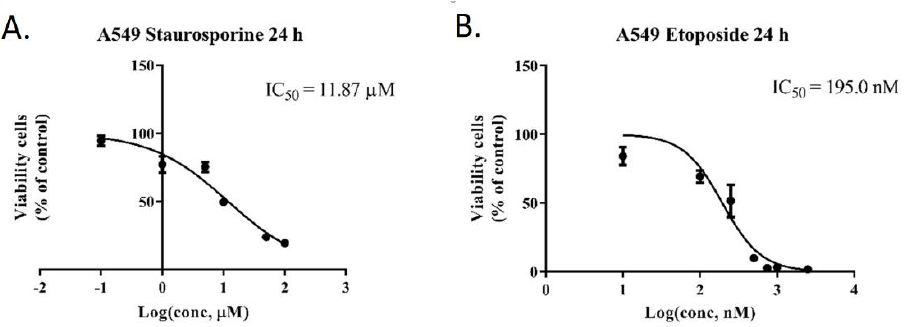
Figure 14. Viability rate of A549 cells treated with various concentrations of staurosporine ( A ) and etoposide ( B ).